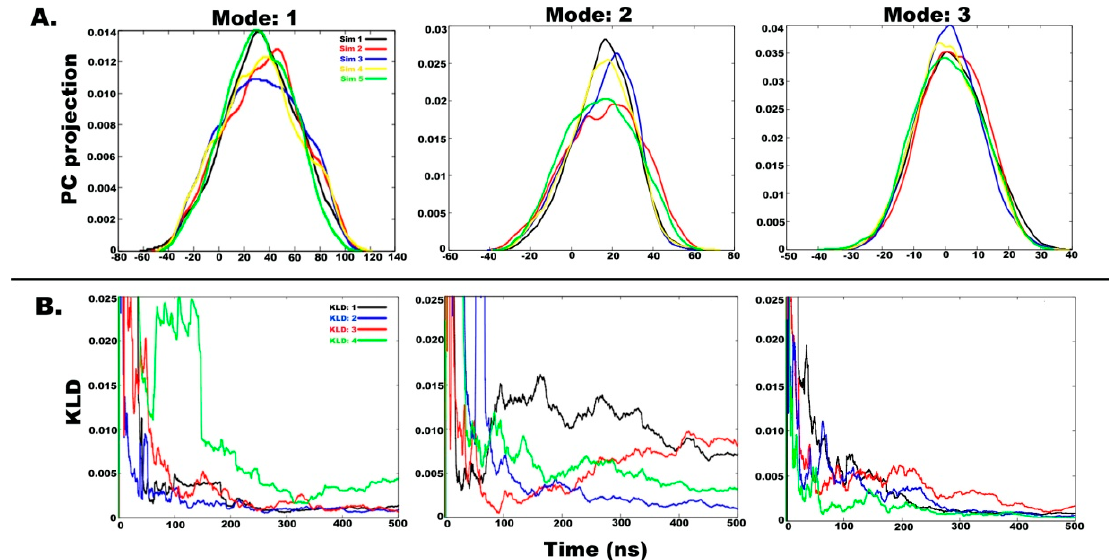
Figure 5. ( A ) Histograms of projection of principal components 1, 2, and 3 for all four simulations in water, where the last 1 µ s long simulation is treated in 2 parts. Histograms were calculated using a Gaussian kernel density estimator. ( B ) A measure of overlap between histograms from independent simulations calculated using the Kullback-Leibler divergence method. The slope values lying below 0.025 indicate convergence between two independent runs.